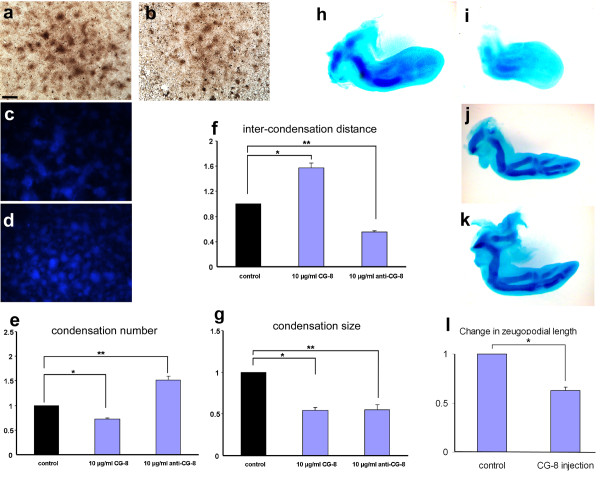
Addition of CG-8 decreases condensation number and density in vitro and impairs digit development in vivo. (a) Staining by PNA of a 2-day control leg culture (b) Culture treated with 10 μg/ml CG-8, showing a decrease in number of condensations, with a concomitant and uniform decrease in their sizes. (c) Control 2-day culture stained with DAPI. (d) Culture treated with 10 μg/ml rabbit polyclonal anti-CG-8 antibody, fixed at day 2, and stained with DAPI. (e) Graph showing change in condensation number upon addition of 10 μg/ml CG-8 and 10 μg/ml polyclonal anti-CG-8 antibody, respectively. Photomicrographs (a-e) are at same level of magnification; scale bar in (a) represents 0.25 mm. (f) Graph showing change in inter-condensation distance upon addition of 10 μg/ml CG-8 and 10 μg/ml polyclonal anti-CG-8 antibody, respectively. (g) Graph showing change in condensation size both upon addition of CG-8 and polyclonal anti-CG-8 antibody, respectively. The three variables (mean condensation number, mean size and mean inter-condensation distance) were compared as in the legend to Figure 5. (h-i) Wing bud (i) injected with CG-8 on 5th day of incubation, fixed and stained with Alcian blue, reveals absence of any cartilage primordia in the autopod and poorly stained, smaller zeugopodial cartilage in comparison with (h) control left wing. (j-k) Right wing bud injected on 5th day of incubation with (j) CG-8 and (k) contralateral untreated control wing bud, both stained with Alcian blue at day 9, showing decrease in length of zeugopodial primordia due to CG-8 treatment. (l) Graph showing decrease in zeugopodial cartilage primordium length when CG-8 was injected into 5-day wing buds. The primordium lengths were analyzed using one-way analysis of variance comparing means by the Tukey-Kramer post-hoc analysis. Results are shown as mean ± S.E.M. (* p < 0.05).